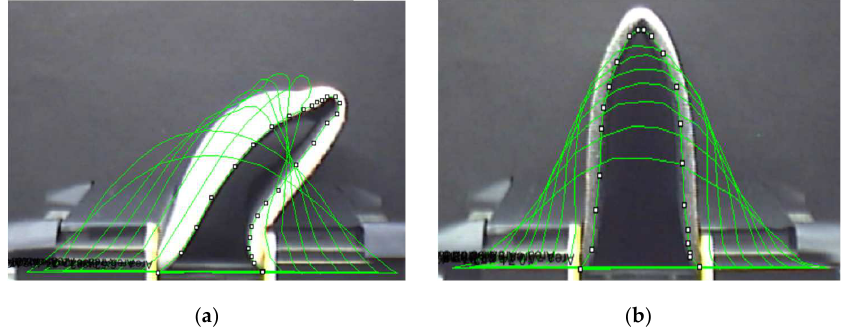
Figure 7. The shape of the bent fabric profile: ( a ) fabric with a defect; ( b ) high-quality fabric.